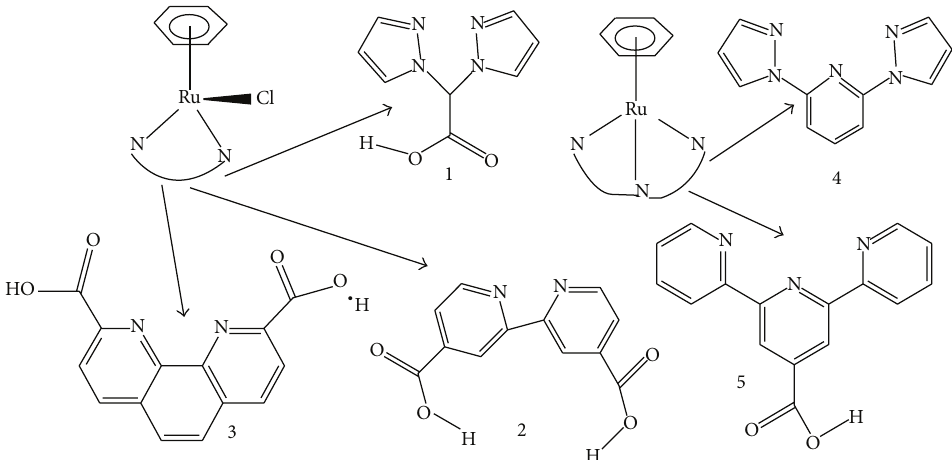
Figure 1: The schematic features showing all the bidentate ligands of complexes 1, 2, and 3 and tridentate ligands of complexes 4 and 5.